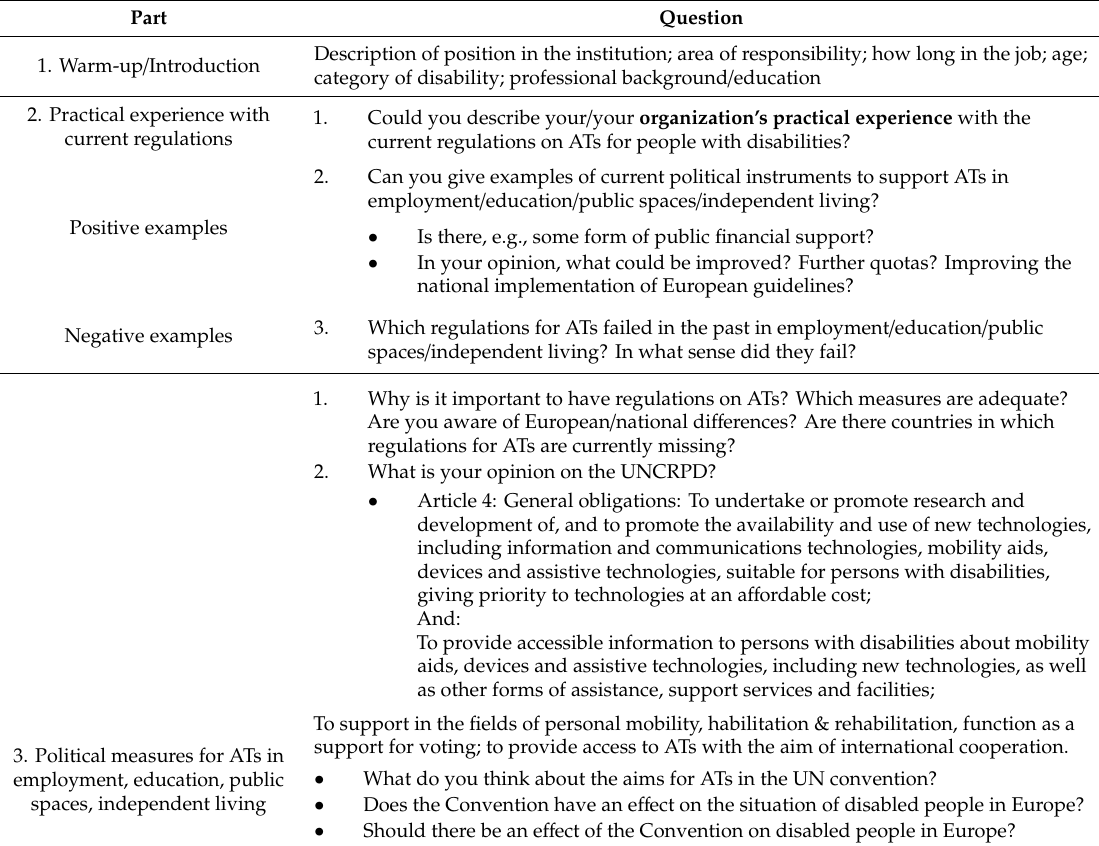
Table A2. Set II—Complementary Measures by the Public